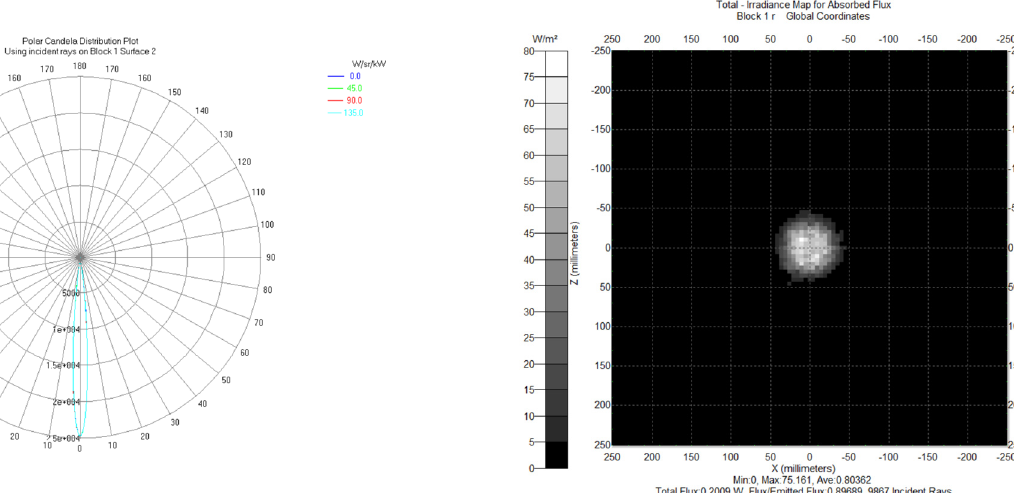
Figure 10. LED light distribution curve after light source design.